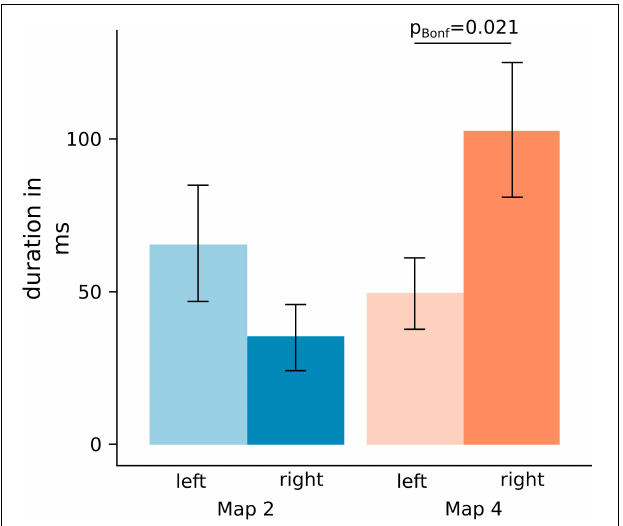
FIGURE 5 | Mean map duration of map 2 (blue) and map 4 (orange) resulting from the backfit on subject CSERPs. Map duration for map 2 did not but for map 4 did differ significantly between left- and right-sided stimulation. Error bars represent SEM. pBonf: Bonferroni corrected p